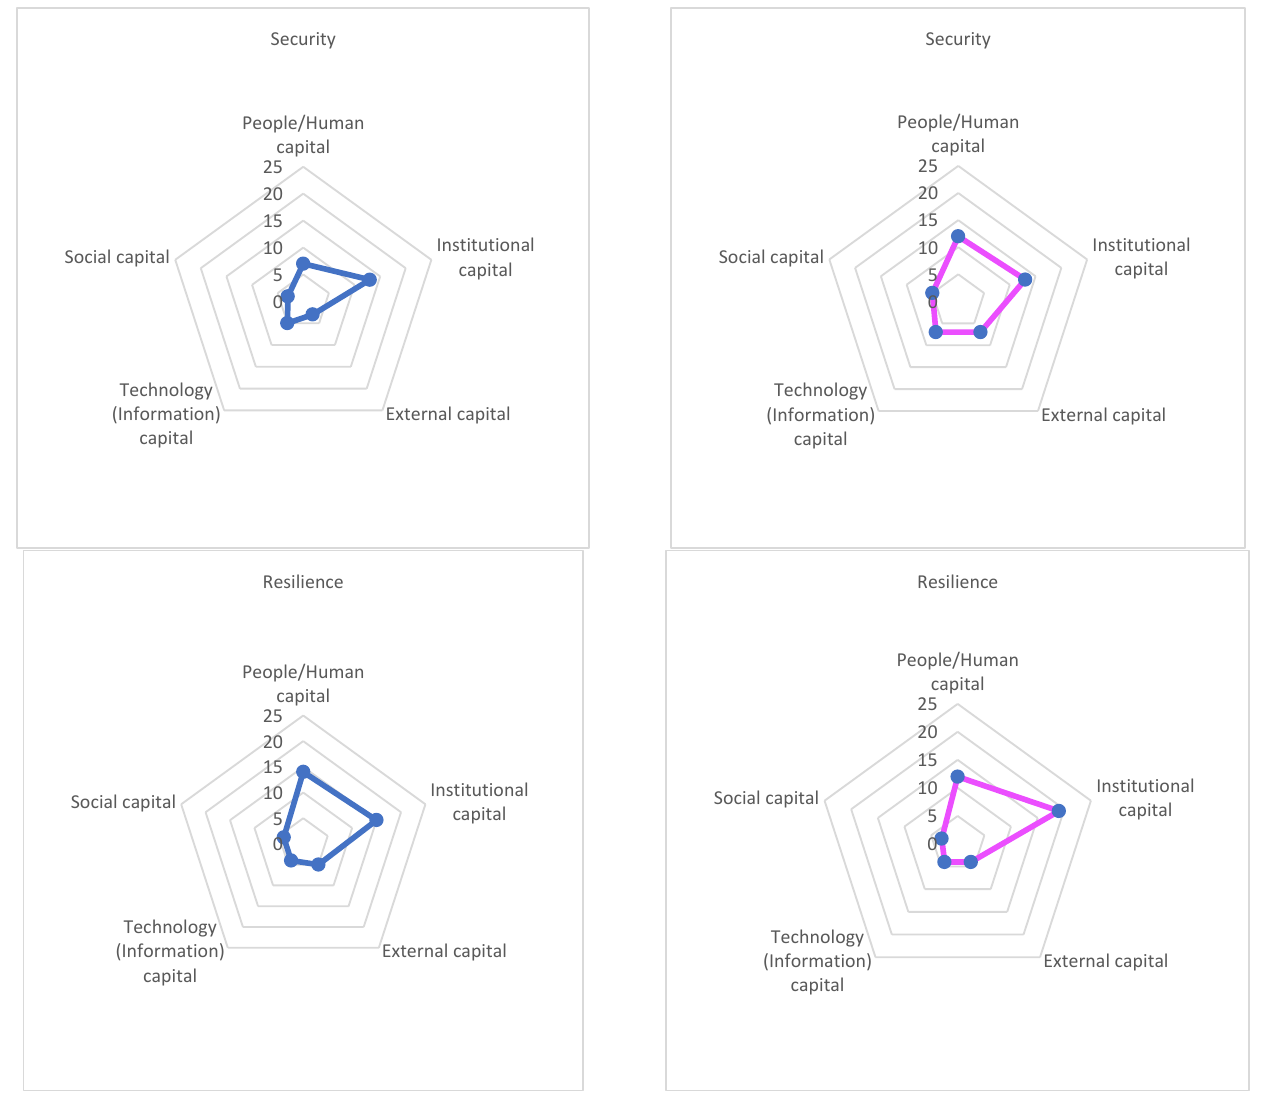
Figure A1. Number of Soft Assets Considerations for Five Soft Asset Capitals.